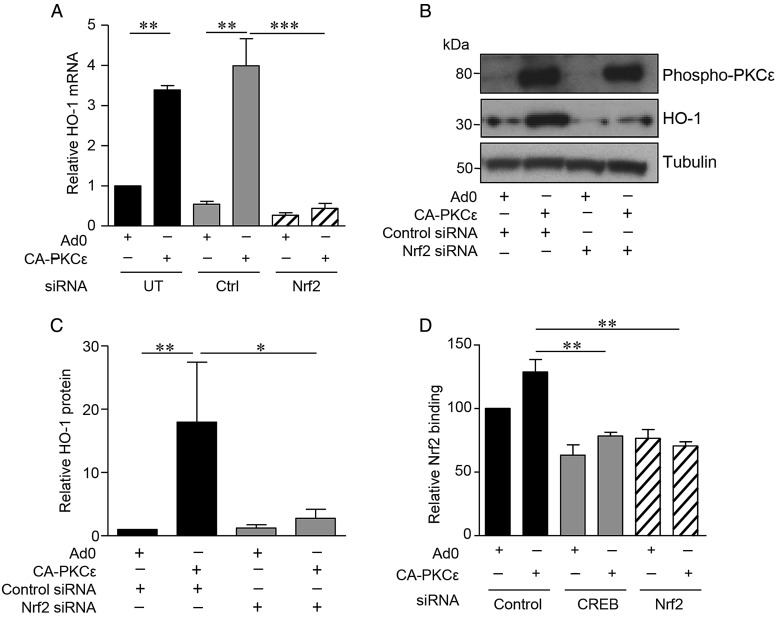
A PKCε-CREB-Nrf2 signalling pathway regulates HO-1 expression in EC. (A) HUVECs were left UT or transfected with pooled Nrf2 or Ctrl siRNA oligonucleotides (40 nM) for 24 h prior to transfection with Ad0 or CA-PKCε for 16 h. HO-1 mRNA levels were analysed by qRT-PCR. Pooled data are shown from three individual experiments and normalized to expression in EC transfected with Ad0 alone. (B and C) HUVECs were transfected with Nrf2 or control siRNA as above, prior to transfection with Ad0 or CA-PKCε for 24 h. HO-1 and phospho-PKCε(Ser729) were analysed by immunoblotting. A representative immunoblot is shown (B), and the histogram (C) shows data from four individual experiments, corrected for tubulin expression, and normalized to control-transfected cells. (D) Nuclear lysates were obtained from HUVECs pretreated with control, Nrf2, or CREB siRNA oligonucleotides for 24 h prior to 16 h transfection with Ad0 or CA-PKCε. Nrf2 translocation was assessed using a DNA-binding ELISA. Pooled data from four independent experiments are shown (mean ± SEM) and normalized relative to Ad0-transfected control cells (ANOVA, *P < 0.05, **P < 0.01, ***P < 0.001).